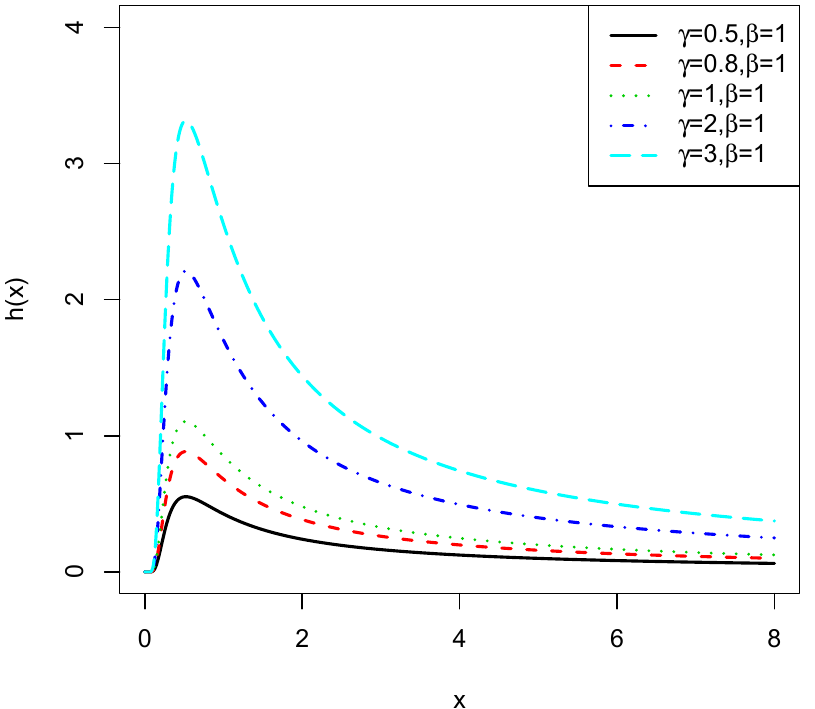
Figure 1. The graph of Hazard function of